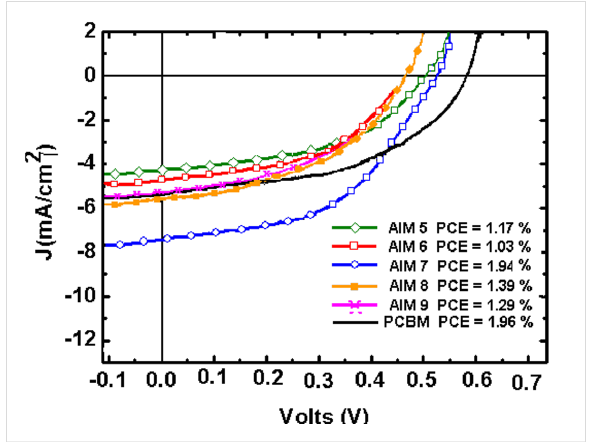
Figure 4: J – V characteristics of P3HT/AIMs and reference P3HT/ PCBM devices for the P3HT/fullerene weight ratio 1:1.